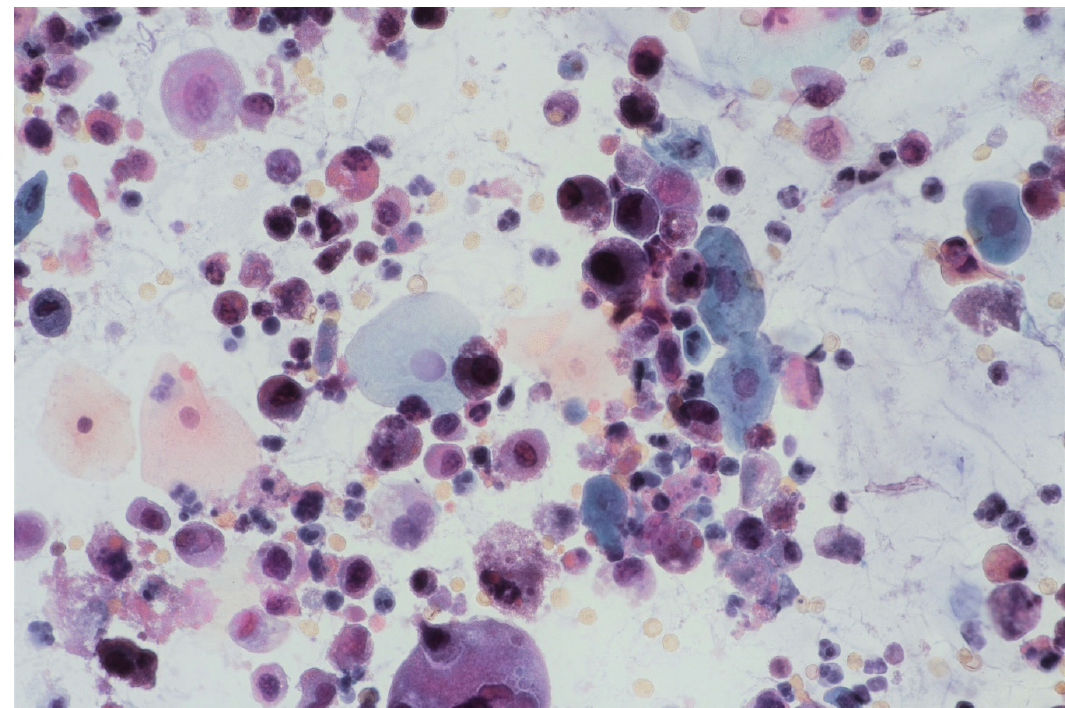
Figure 1. Urine sediment—a cytological specimen. Papanicolau staining. Urothelial carcinoma cells with a high N/C (nucleus/cytoplasm) ratio (~30% of cells with N/C ratio ≥ 0.7 and ~20% with N/C ratio ≥ 0.5 and <0.7), nuclear margin irregularity and hyperchromasia. Prominent single or multiple nucleoli and mitoses. An inflammatory background of the specimen is visible with numerous granulocytes and erythrocytes.